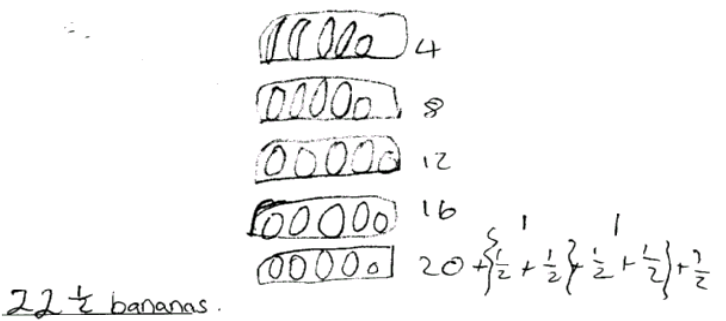
Figure 6 : Violet’s solution to the banana bread